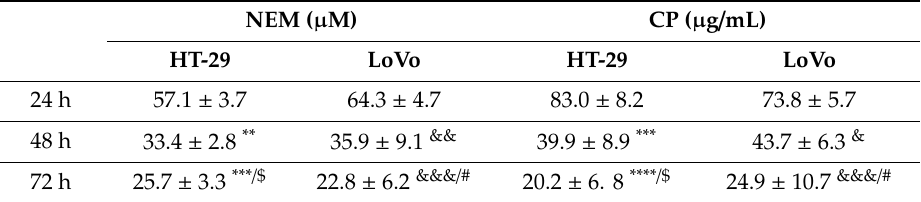
Table 1. IC 50 values of NEM and Cuban propolis (CP)